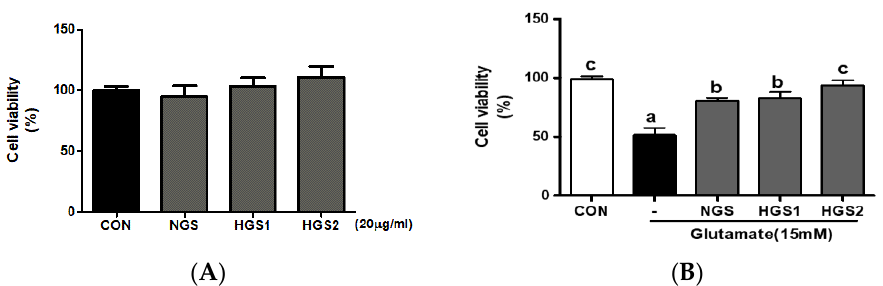
Figure 2. Inhibitory effect of HGS on glutamate-induced oxidative stress in PC12 cells. ( A ) PC12 cells were treated with HGS (20 μg/mL) and the control (0.2% DMSO) for 48 h. ( B ) PC12 cells were treated with HGS (20 μg/mL) and then with 15 mM glutamate for 48 h. Significance was determined by a one-way ANOVA with Tukey’s post hoc multiple comparison tests. Data are means ± standard errors of the mean (SEM). The values marked by different letters in a, b and c were found to differ significantly at p < 0.05 by Duncan’s multiple range test.